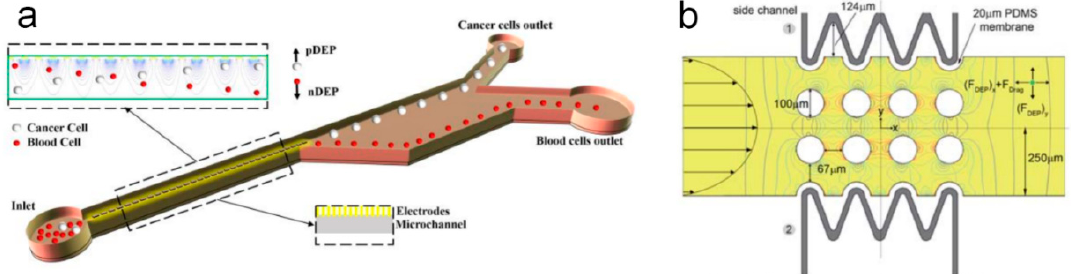
Figure 12. ( a ) Example of dielectrophoretic cell separation in the microfluidic device. Reprinted with permission from [199]. Copyright 2017, John Wiley and Sons. ( b ) Schematic of contactless dielectrophoretic (cDEP) device with the electromagnetic forces acting in the microfluidic channel. Reprinted with permission from [201]. Copyright 2010, the Royal Society of Chemistry.